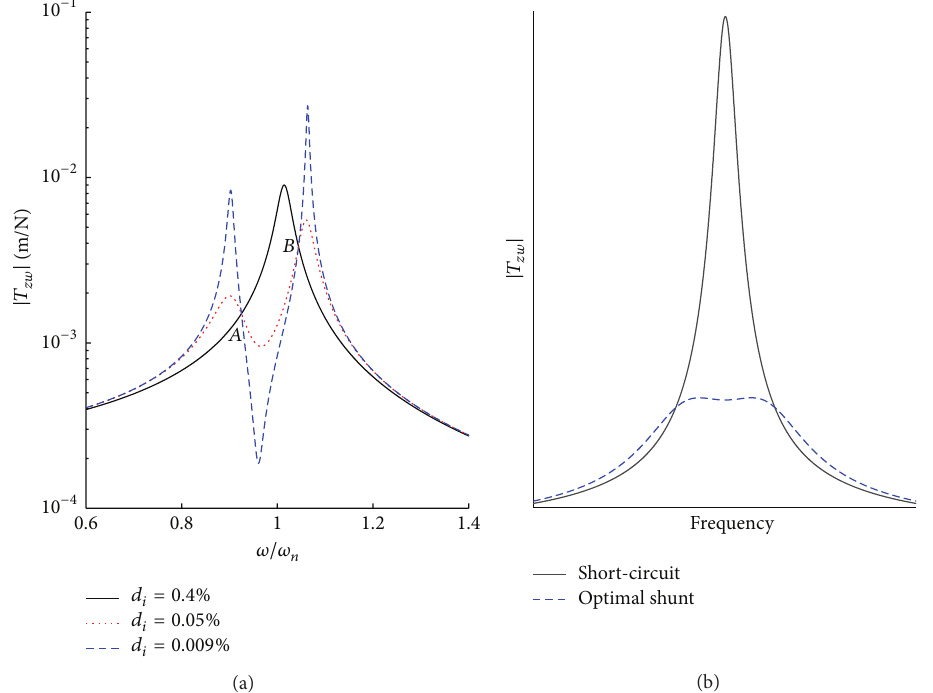
Figure 3: |𝑇 𝑧𝑤 | for an undamped elastic structure (a) and trend of |𝑇 𝑧𝑤 | for a generic system with the optimal value of 𝑑 𝑖 (b).